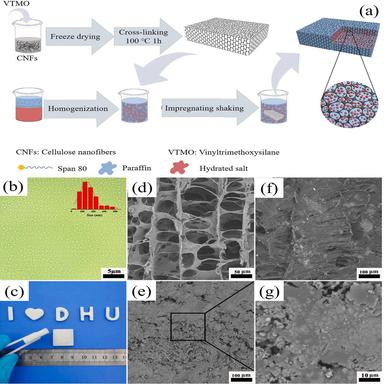
(a) Schematic illustration of the preparation process of shape-stabilized phase change materials (SSPCMs), Morphology of the SSPCMs: (b) Optical microscope image of the hydrated salt/parafn inverse emulsion, inset shows the size distribution of more than 200 emulsion droplets, (c) Digital picture of the SSPCMs and (d, e, f, g) SEM images of the cross-section of CS, SSPCMs, parafn/CS, and a partial enlargement of Fig. 5e, respectively. Reproduced with the permission of Elsevier.